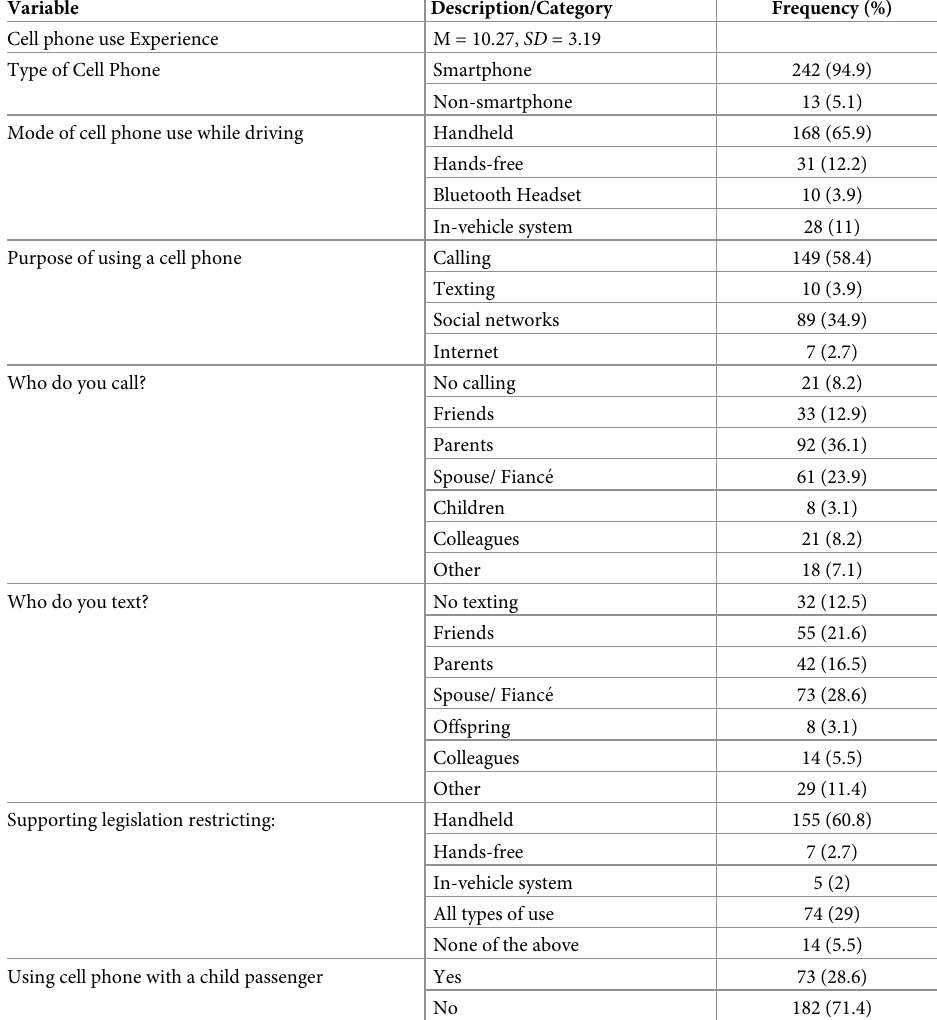
Table 2. Types of use, peer-users and support for legislation by type of